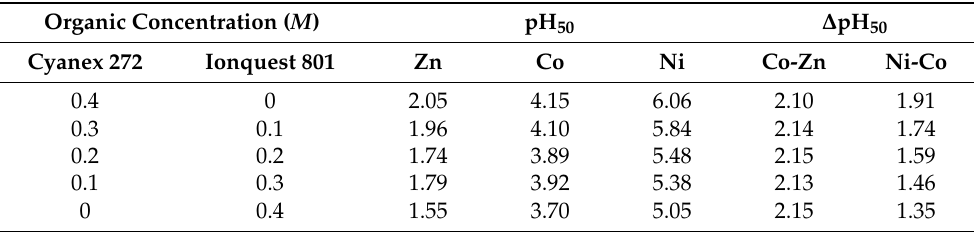
Table 5. The half extraction of pH 50 and ∆ pH 50 (Co-Zn and Ni-Co) with various organic compositions composed of Cyanex 272 and Ionquest 801.